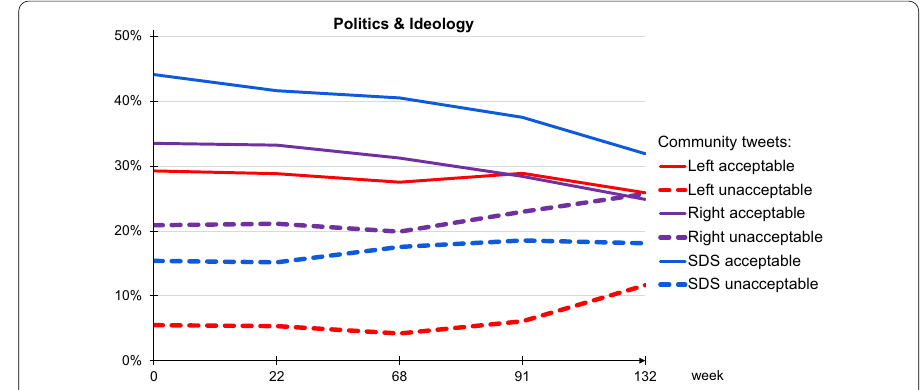
Fig. 6 Evolution of the two topics merged, politics and ideology, for the three major communities: Left (red), Right (violet), and SDS (blue). Solid lines represent acceptable tweets, and dashed lines correspond to unacceptable tweets. The y-axis represents percentages of tweets with a topic of politics or ideology out of all the tweets posted or retweeted by a community. The x-axis are the five timepoints at weeks t = 0,22,68,91,132